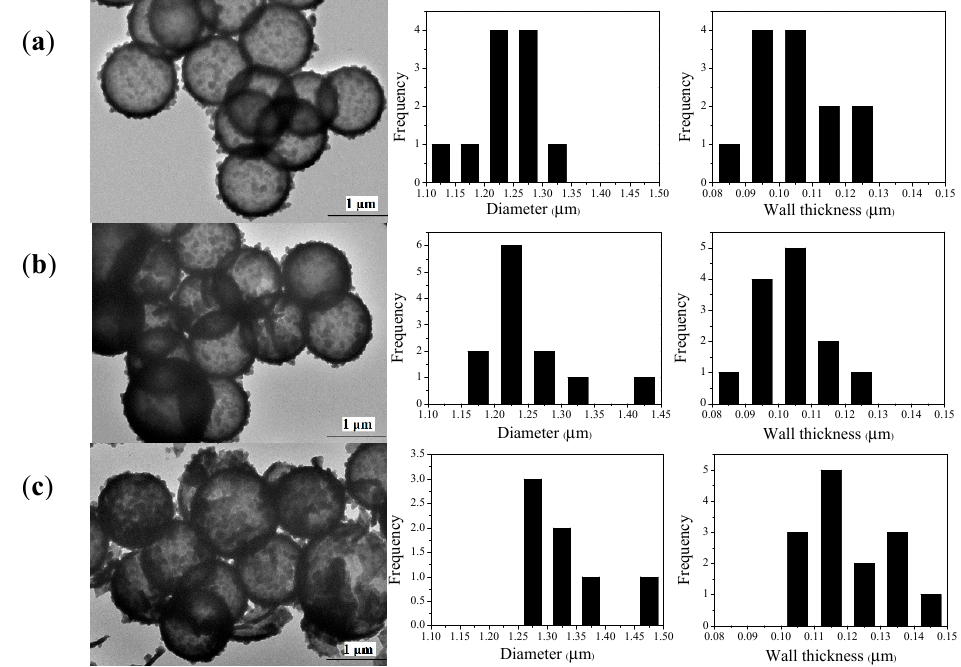
Figure 5. Transmission electron microscope (TEM) images of ( a ) hollow spheres, ( b ) HS- g -PMMA, and ( c ) HS- g -PMMA- b -PNIPAM.